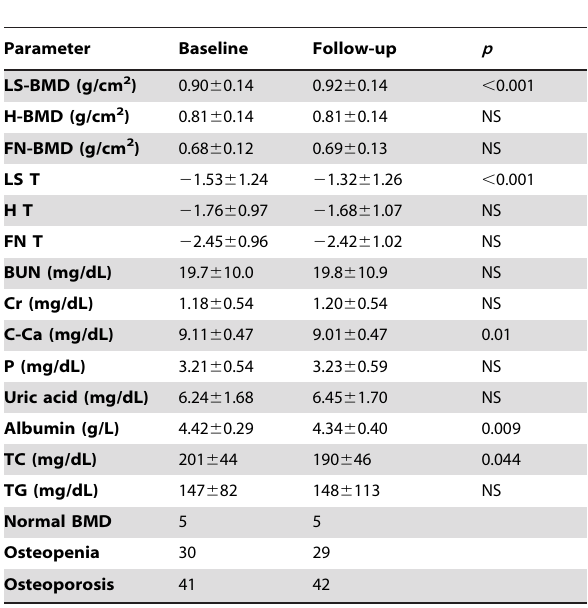
Abbreviations: BMD, bone mineral density; BUN, blood urea nitrogen; C-Ca, serum corrected calcium; CMV, cytomegalovirus; Cr, blood creatinine; DM, diabetes mellitus; HBV, hepatitis B virus; HCV, hepatitis C virus; FN, femoral neck; H hip; LS, lumbar spine; NS, not significant ( p . 0.05); P, serum inorganic phosphate; T, number of standard deviations above or below the mean value of BMD for sex-matched young adults; TC, serum total cholesterol; TG, serum triglyceride. LS-BMD was significantly greater at follow-up than at baseline. The albumin and calcium levels also decreased significantly, but they remained within normal ranges.